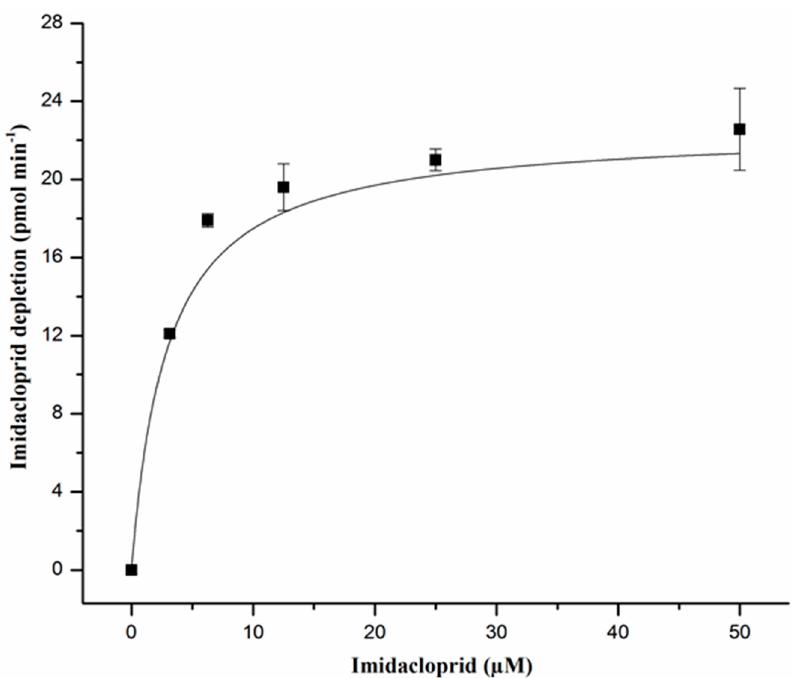
Figure 5. Michaelis–Menten kinetics of imidacloprid detoxification by functionally expressed CYP353D1v2, analyzed by non-linear regression. Data points are mean values ± SD ( n = 3). The Km value was determined as 6.41 ± 1.27 µM.